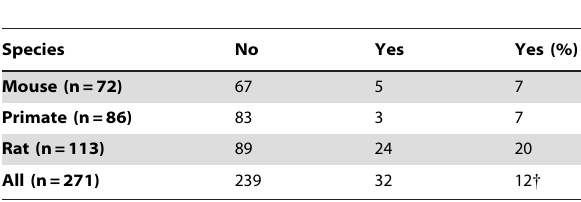
Table 13. Number of studies that reported using